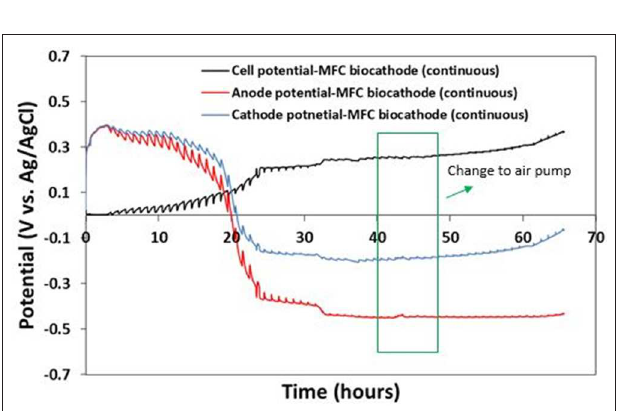
FIGURE 7 | Cell, anode, and cathode potentials of MFC with IOB biocathode operated in continuous mode. Green box shows the time between hours 40 and 48 that catholyte reservoir tank was aerated using an aquarium air